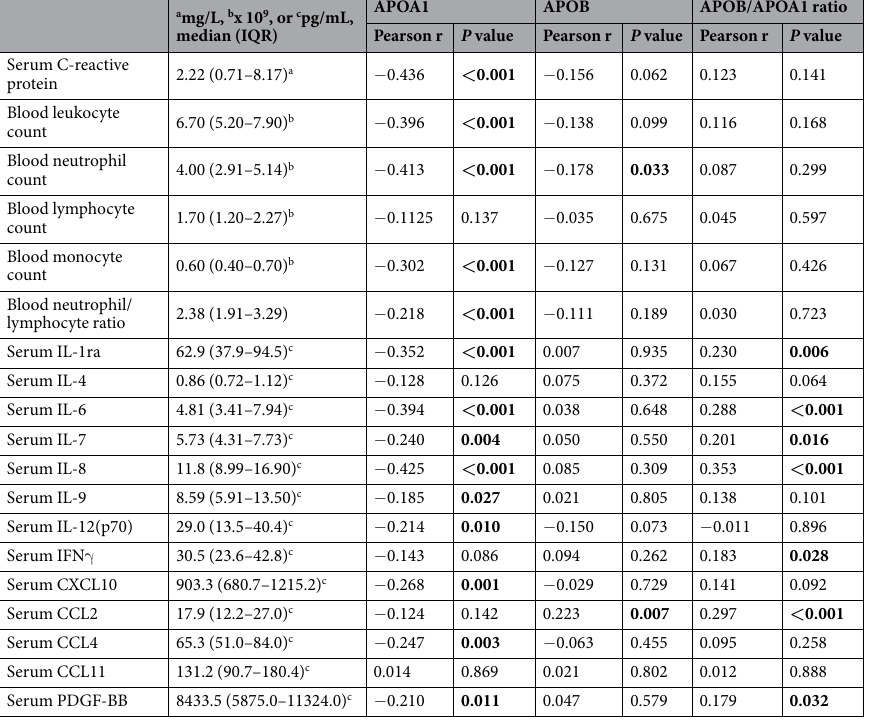
Table 3. Correlations between serum APOA1, APOB and systemic inflammatory markers. Abbreviations: IL: interleukin; IFN: interferon; CCL: chemokine (C-C motif) ligand; PDGF: platelet-derived growth factor. Numbers indicate Pearson correlation coefficients (r) for logarithmically transformed